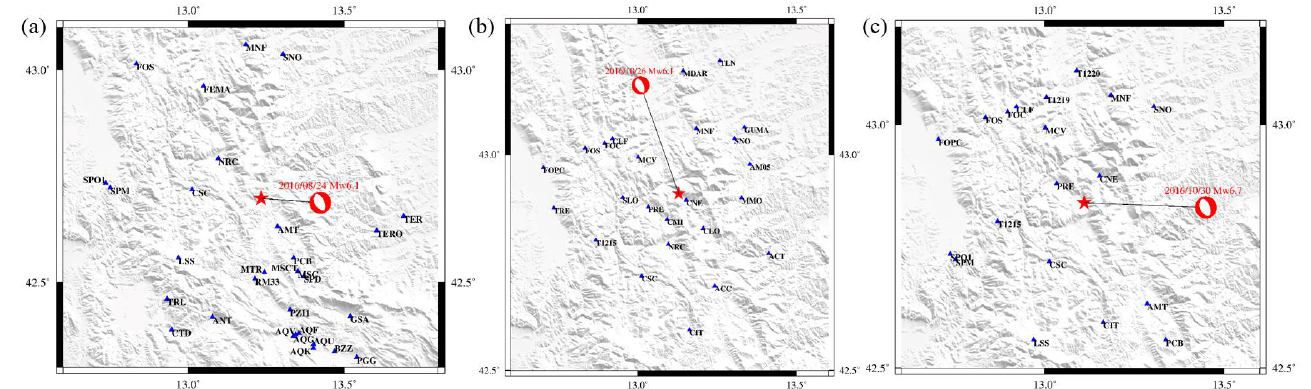
Figure A2. Distribution of the strong-motion stations used to retrieve the slip models of the Amatrice ( a ), Visso ( b ), and Norcia ( c ) earthquakes.